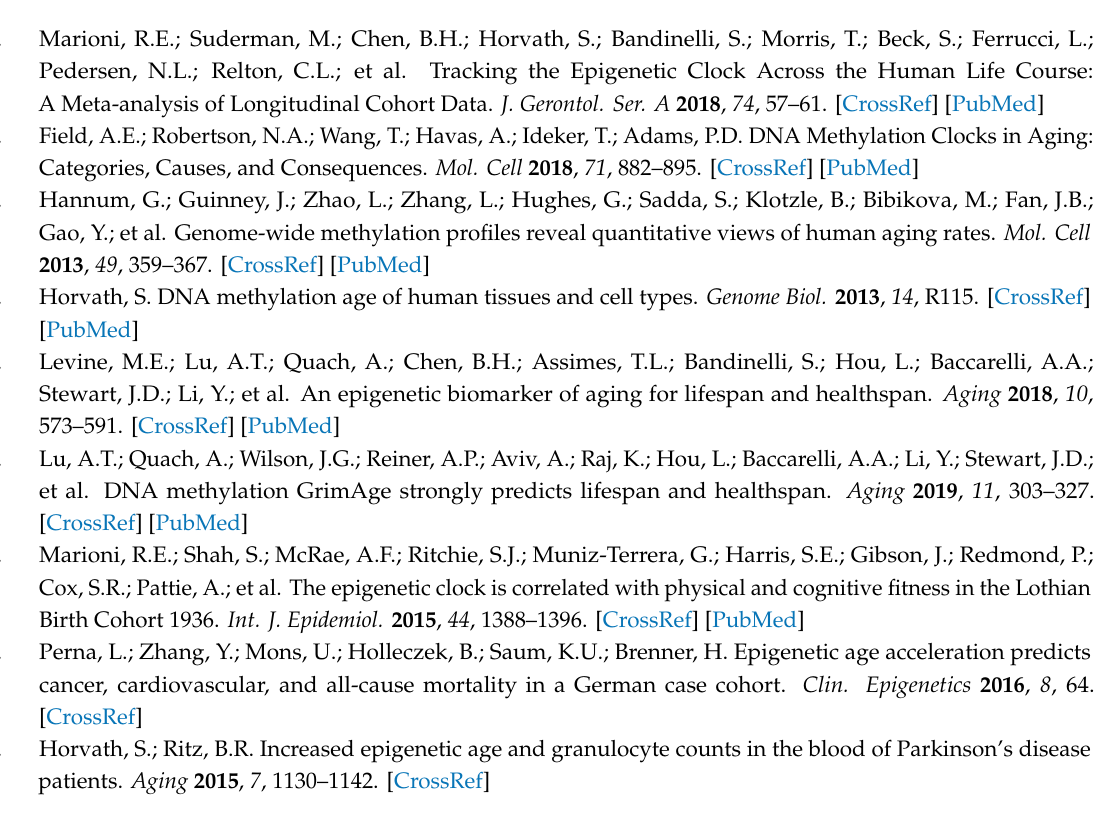
Figure S1: Scatterplots of DNAm Age estimators vs. chronological age for participants in the Genetic Epidemiology Network of Arteriopathy (GENOA, Phase 1); Table S1: Pairwise correlation between DNAm Age estimates, DNAm Age acceleration estimates and chronological age; Table S2: Association of DNAm Age acceleration with education and lifestyle factors (Model 1); Table S3: Association of DNAm Age acceleration with education and lifestyle factors (including physical activity) using multivariable models (Model 2); Table S4: Association of DNAm Age acceleration with education and lifestyle factors using multivariable models in hypertensive participants (Model 2, N = 771); Table S5: Association of DNAm Age acceleration with education and lifestyle factors adjusting for blood cell proportions; Table S6: Interaction between lifestyle risk factors and gender on GrimAA, adjusting for blood cell proportions; Table S7: Associations of GrimAge components with education and lifestyle factors (Model 2); Table S8: Associations of DNAm GrimAge components with demographic and lifestyle factors, adjusting for blood cell proportions; Table S9: Association between education and lifestyle factors on longitudinal change in DNAm Age acceleration (Model 4); Table S10: Associations between education and lifestyle factors and longitudinal change of DNAm Age acceleration, adjusting for blood cell